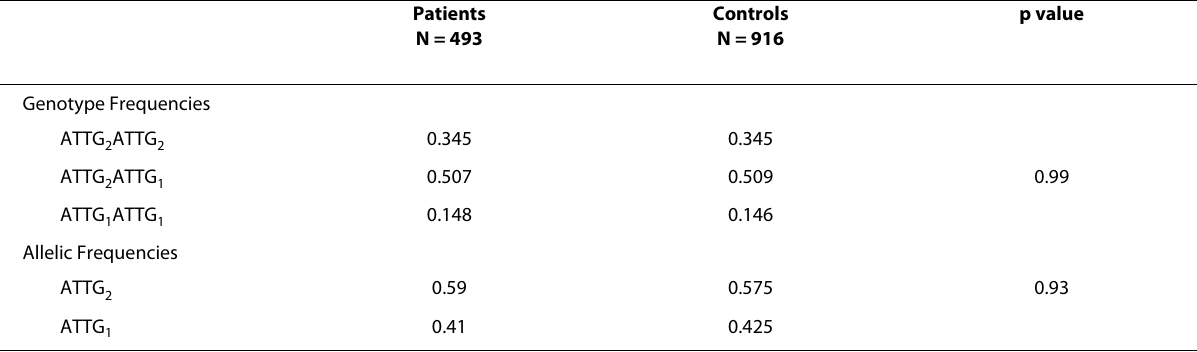
Table 1: Allelic and genotype frequencies of NFKB1 -94 insertion/deletion among pacients and control.